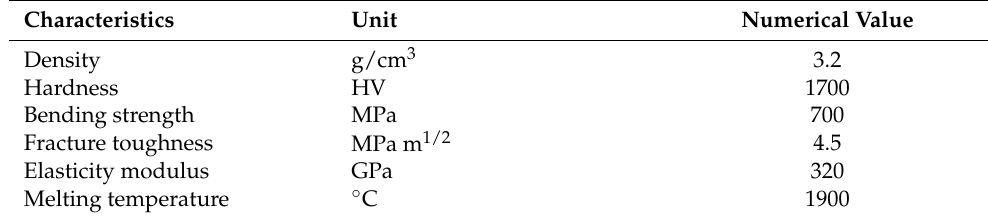
Table 1. Silicon nitride mechanical and physical properties.